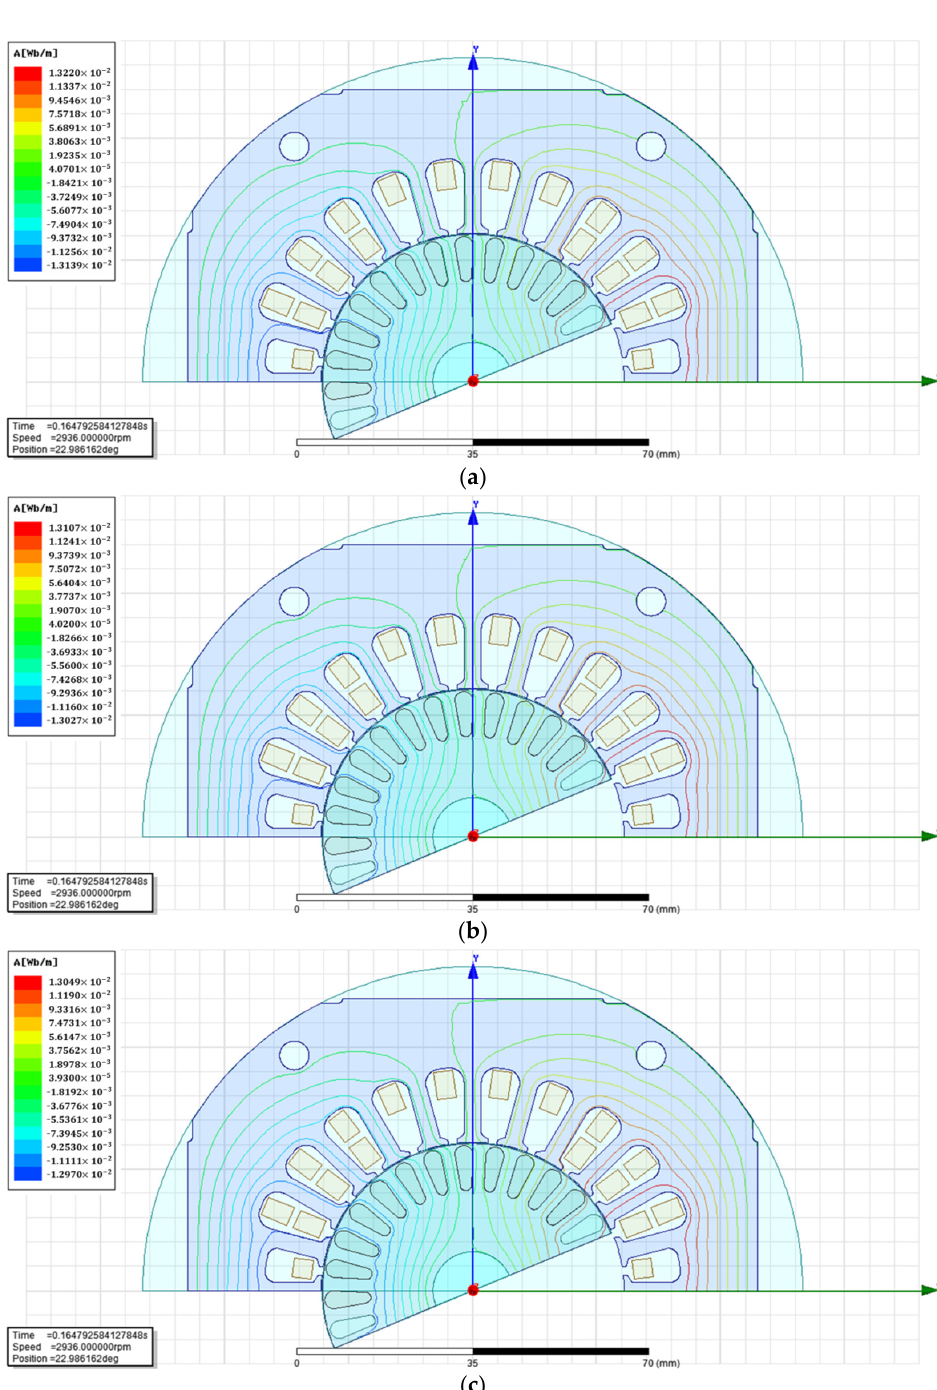
Figure 6. Magnetic field distribution according to the fill factor of the rotor. ( a ) 85%; ( b ) 95%; ( c )